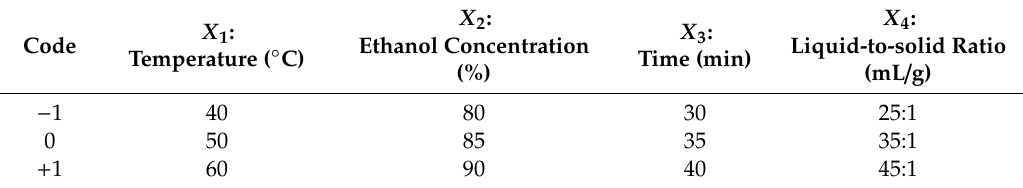
Table 7. Independent variable codes and levels in experimental design.